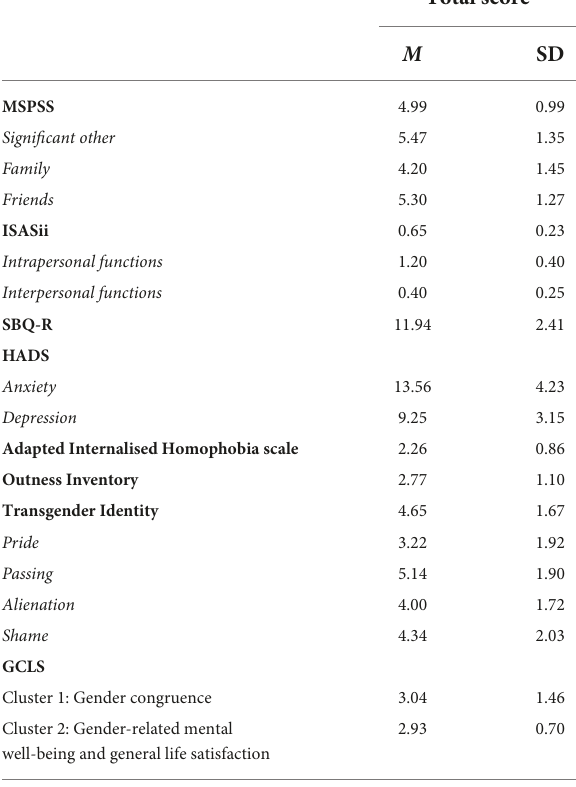
TABLE 3 Baseline measures descriptives [mean ( M ); standard deviation